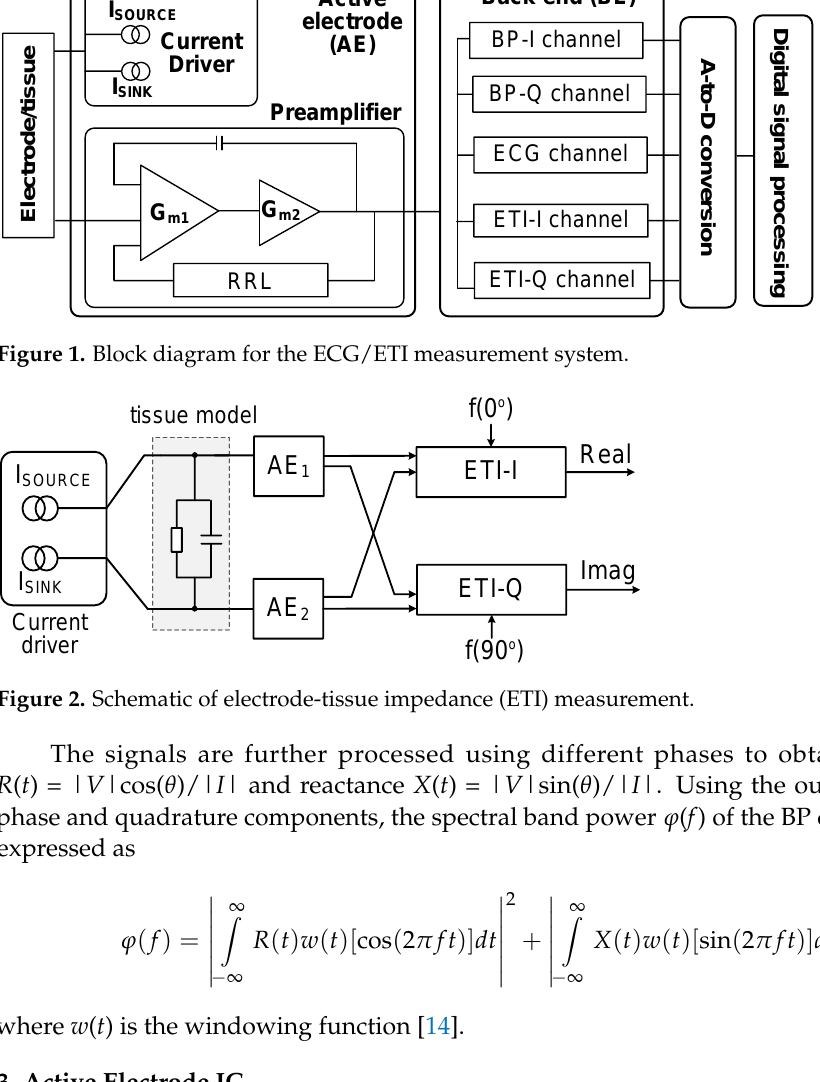
Figure 1. Block diagram for the ECG/ETI measurement system.